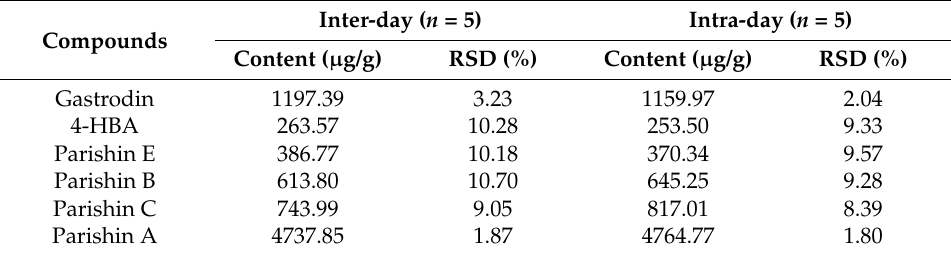
Table 5. Inter-day and intra-day tests for six parishin